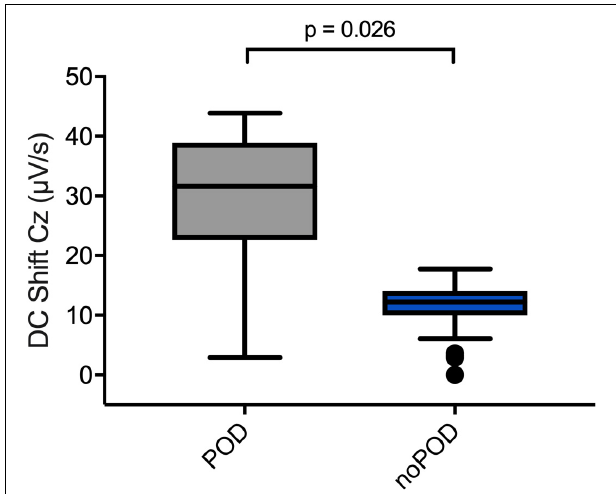
FIGURE 7 | Direct current shifts in POD vs. noPOD patients. Boxplots comparing DC shifts at the Cz electrode at LOC in patients with and without postoperative delirium (POD vs. noPOD). Patients with postoperative delirium (POD) ( n = 6) presented with significantly larger DC shifts compared to patients without delirium (noPOD) ( n = 6). Non-parametric Mann–Whitney U test was used for group comparisons.